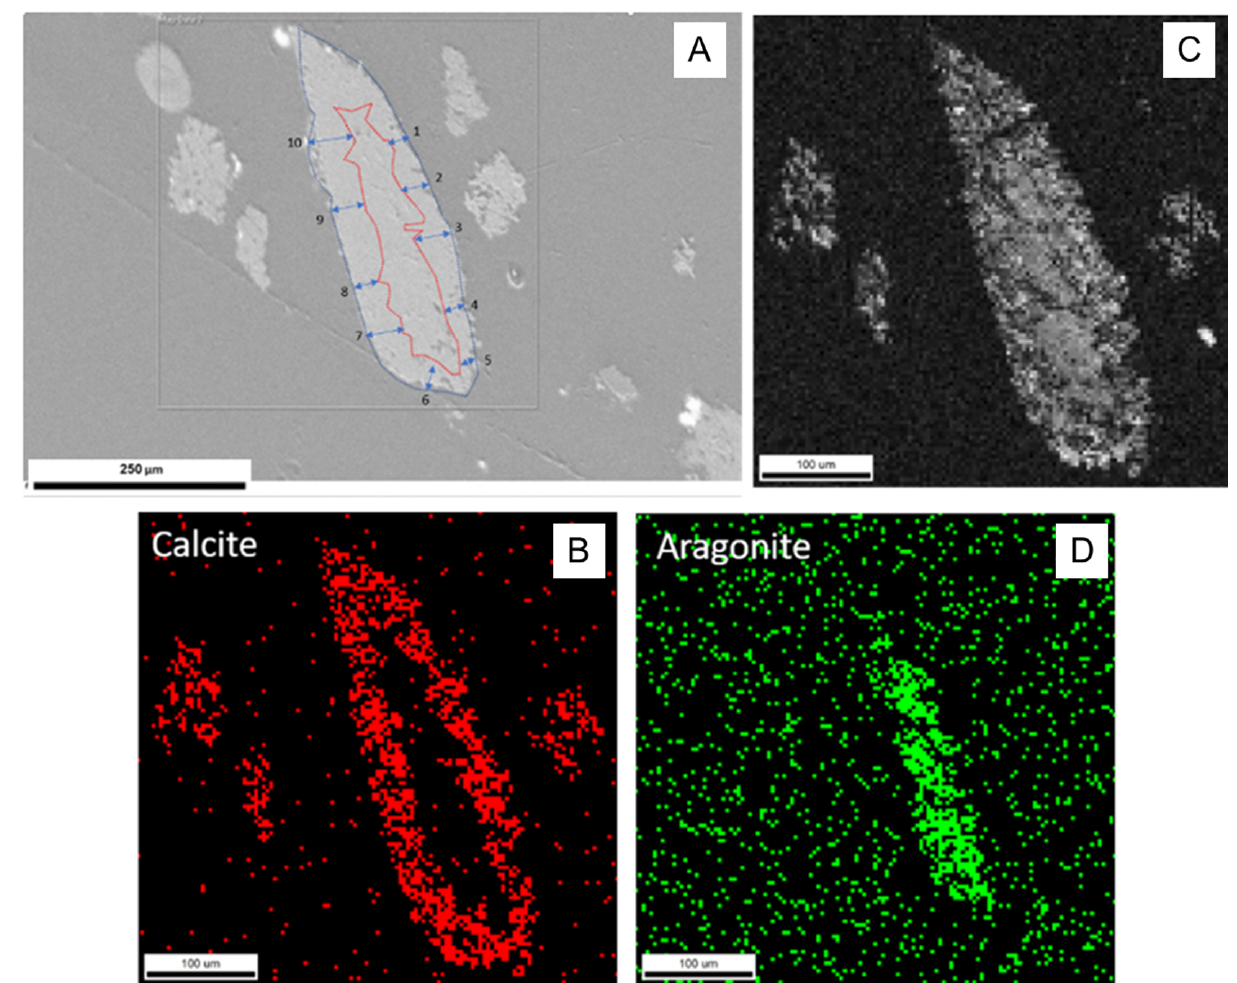
Figure 4. EBSD data showing incomplete transformation of aragonite to calcite in sample A1 (162 °C, 1152 h): ( A ) SEM image of the analyzed crystal, the red line presents the boundary between aragonite and newly formed calcite, 10 locations of calcite rim widths were measured; ( B ) red pixels represent the phase map for calcite, showing its presence in the crystal rim; ( C ) diffraction intensity map; ( D ) green pixels represent the phase map for aragonite, showing its presence in the crystal core.